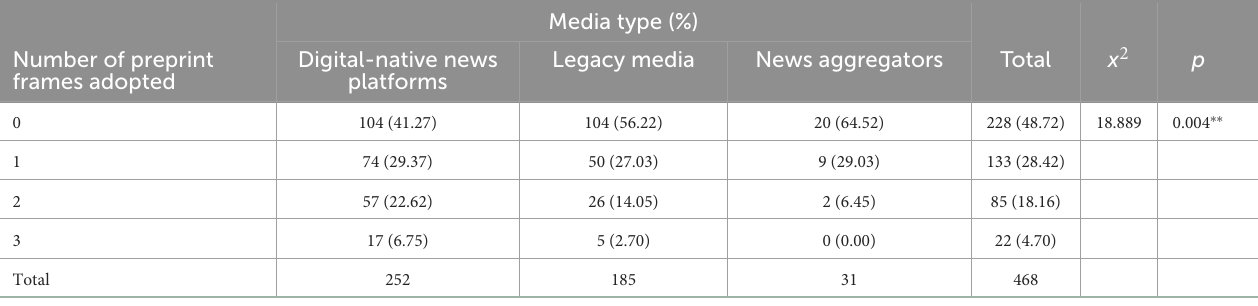
TABLE 6 Chi-square test (cross-tabulation) results for the media type and the number of preprint frames